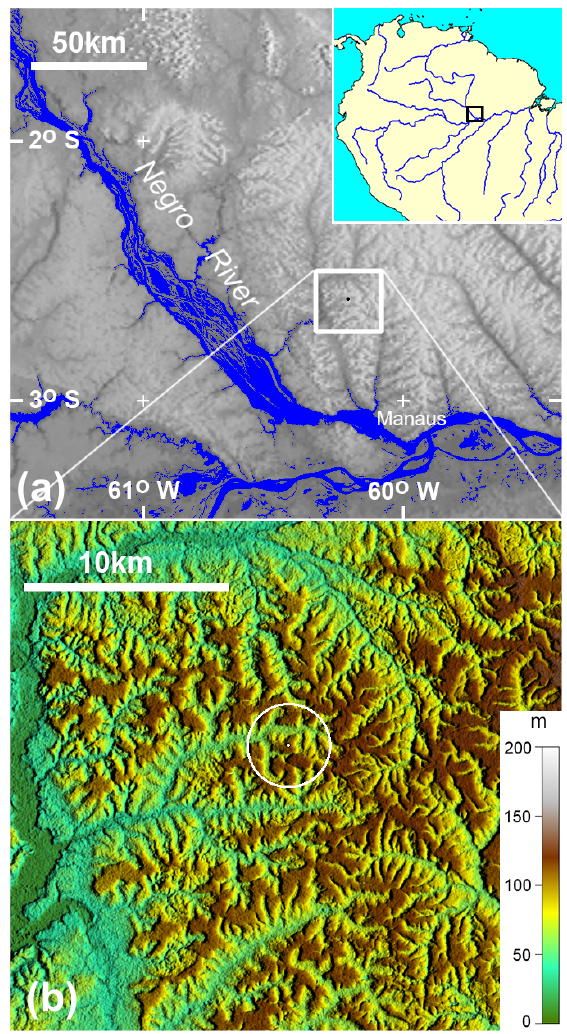
Figure 1. Location of the experimental site in central Amazonia – K34 tower. Hill-shaded digital elevation data used as background topography are from the Shuttle Radar Topography Mission, with resolutions of ∼ 900m (a) and ∼ 30m (b) . The white ring indicates a 2km radius around the flux tower. The elevation scale for panel (b) is meters above sea